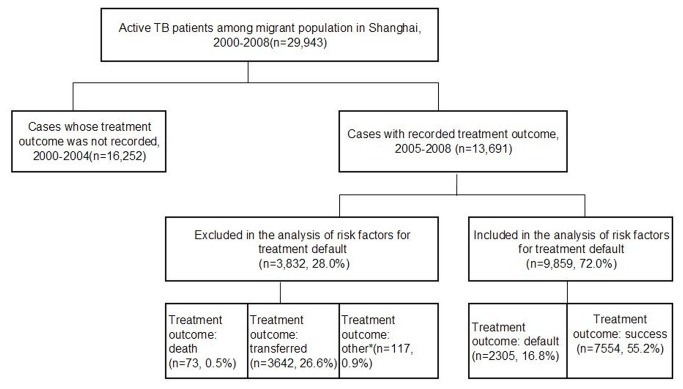
Study population of active tuberculosis (TB) patients among urban migrants in Shanghai, 2000-2008.Cases with treatment outcomes other than treatment success or treatment default were excluded from the analyses. *Includes patients whose tests indicated they did not have tuberculosis and whose anti-TB therapy was therefore discontinued, and TB patients who were still on treatment after one year of therapy.